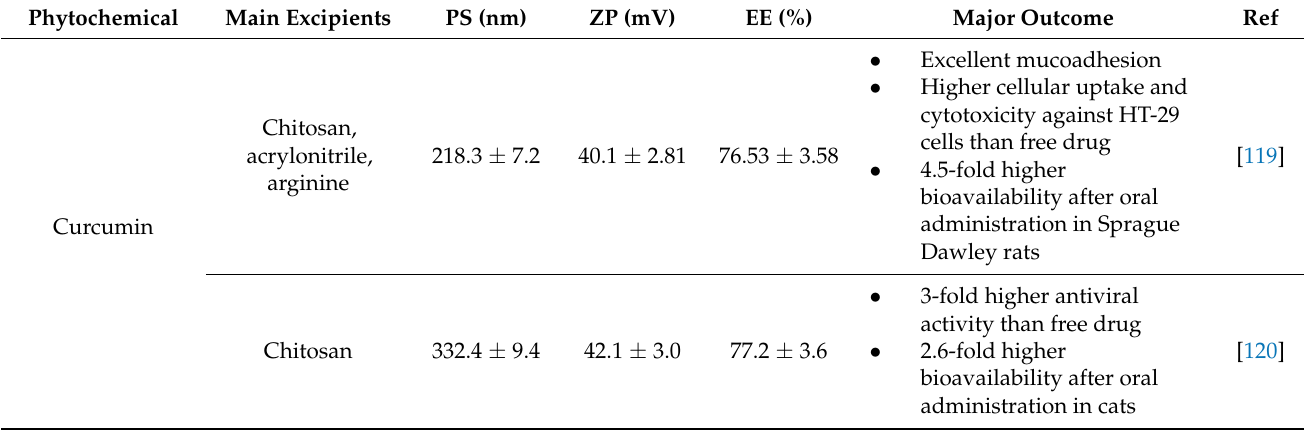
Table 4. Summary of major outcomes after oral administration of selected phytochemicals encapsulated in CS-NPs. Phytochemical Main